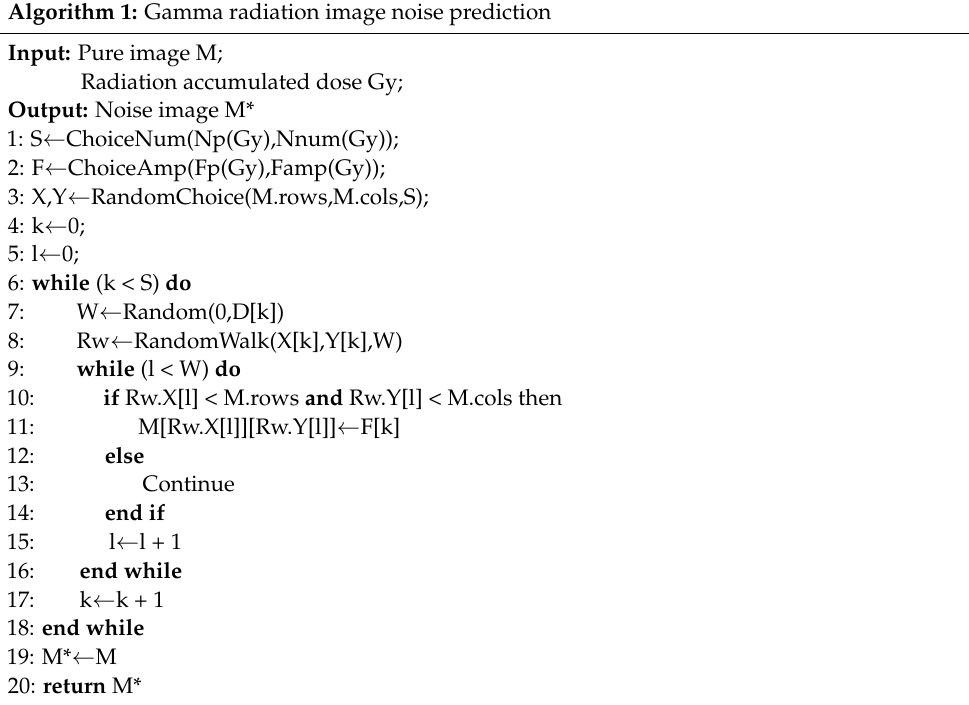
Algorithm 1: Gamma radiation image noise prediction